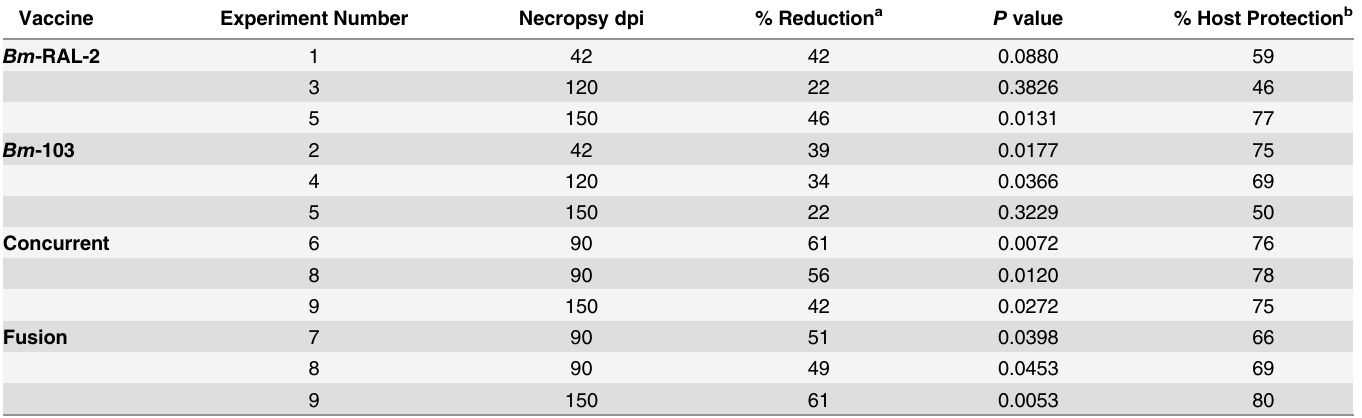
Table 2. Vaccine efficacy, percentage reduction in worm recovery and host protection induced by vaccination of gerbils with Bm -RAL-2 and Bm - 103 individually, concurrently or as a fusion protein.